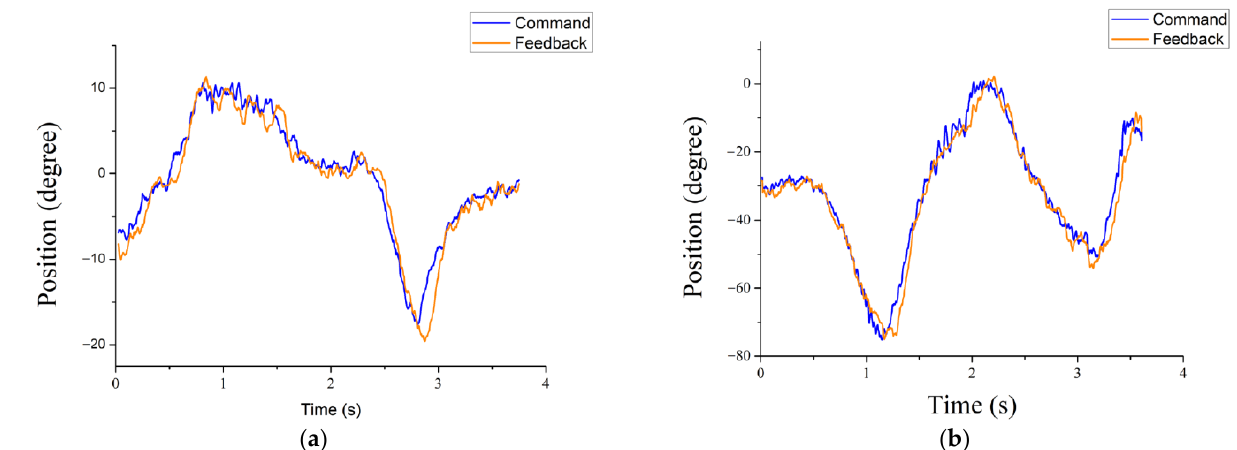
Figure 19. Tracking performance of ( a ) hip ( b ) knee by the conventional controller.